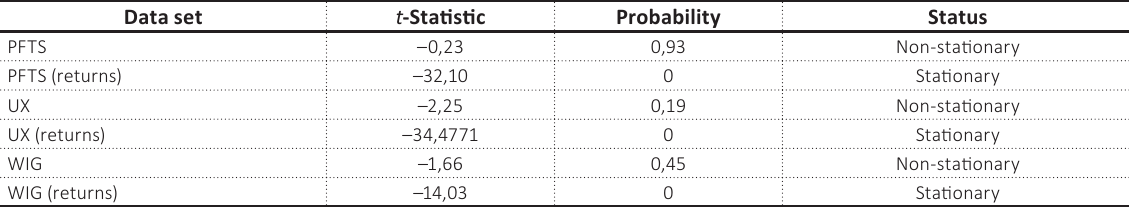
Table 5. Stationarity tests for the ESG and conventional indices Data